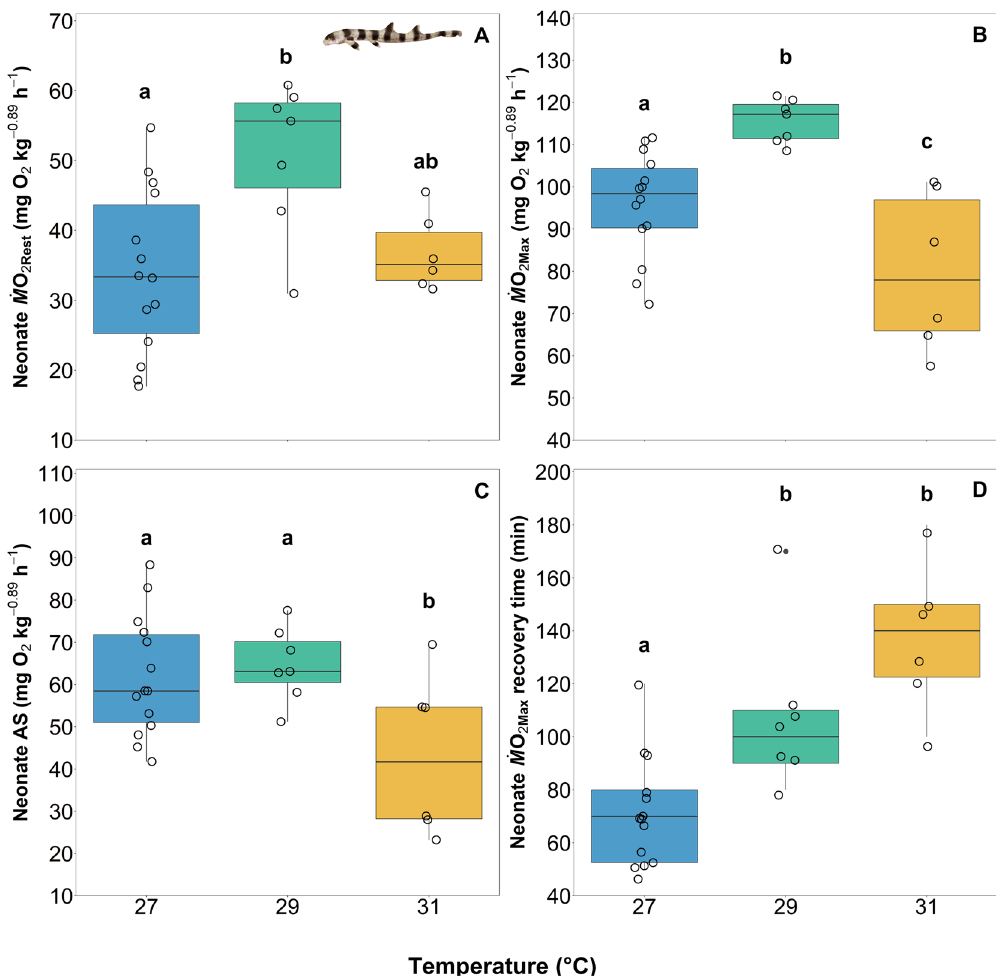
Figure 4. Boxplots of the M ̇ O 2Rest (mg O 2 kg −0.89 h −1 ) ( A ), M ̇ O 2Max (mg O 2 kg −0.89 h −1 ) ( B ), aerobic scope (AS) ( M ̇ O 2Max — M ̇ O 2Rest ; mg O 2 kg −0.89 h −1 ) ( C ), and recovery time (min) from M ̇ O 2Max ( D ) for neonates across three rearing temperature treatments of 27, 29, and 31 °C. Boxes and whiskers represent the median, 25th, and 75th quartiles and 10 and 90th percentiles, respectively. The filled circles represent outliers, and open circles represent observations. Differing lowercase letters denote statistically significant differences at α = 0.05 (see